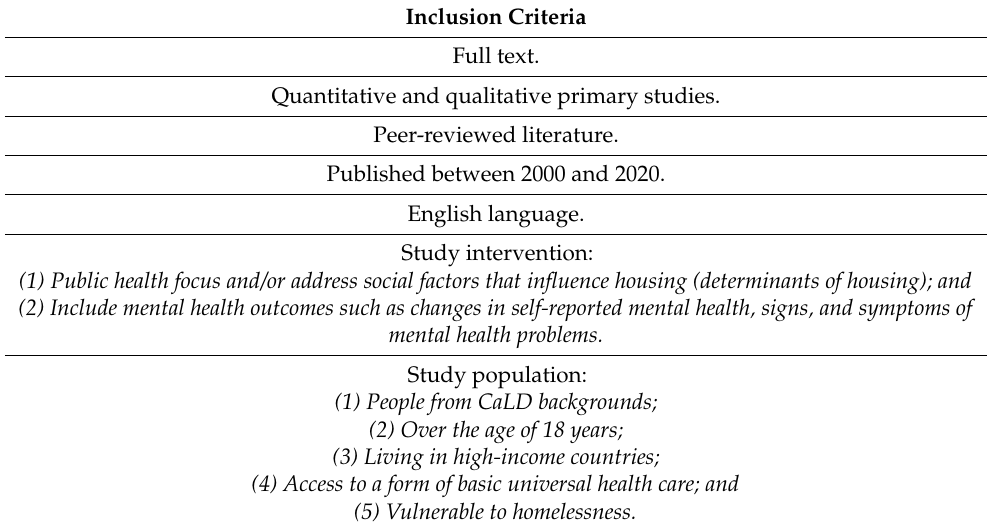
Table 1. Inclusion criteria for studies.